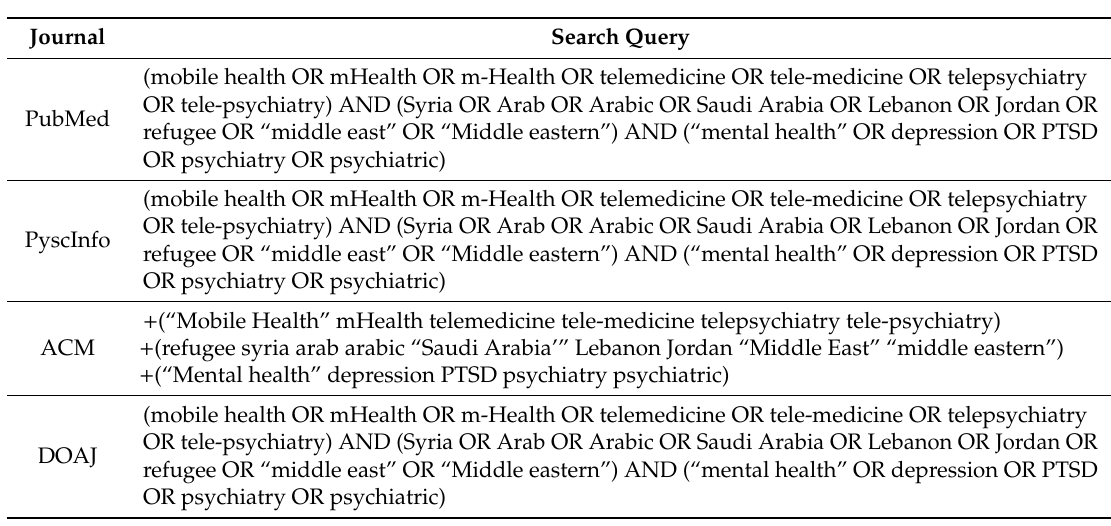
Table 2. PubMed, PsychInfo, ACM and DOAJ Boolean Search Queries.